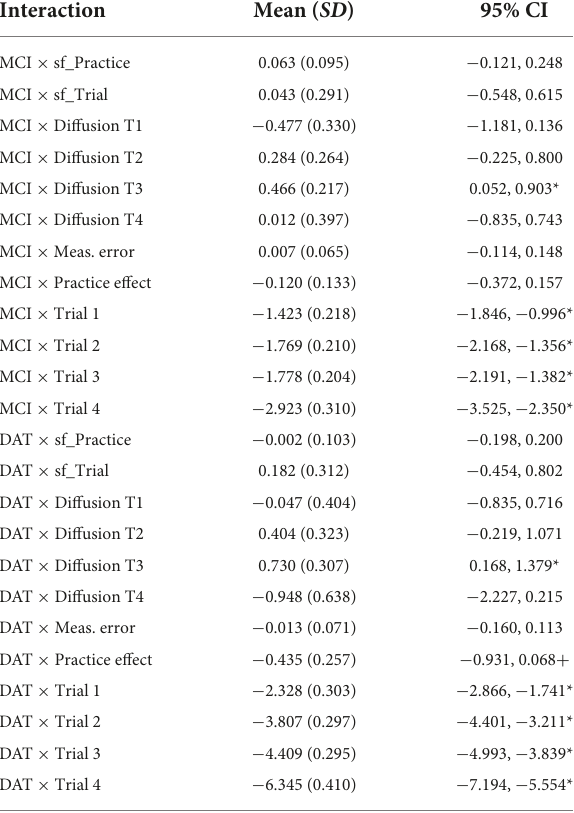
TABLE 4 Effects of diagnostic groups in the total